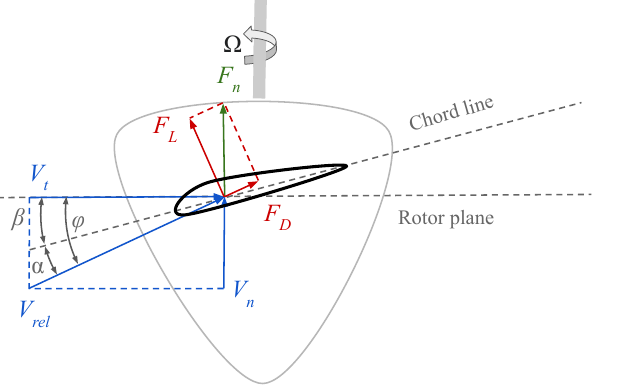
Figure 11. Schematic plot of the velocity and force triangles on a rotating wind turbine blade based on the BEM theory